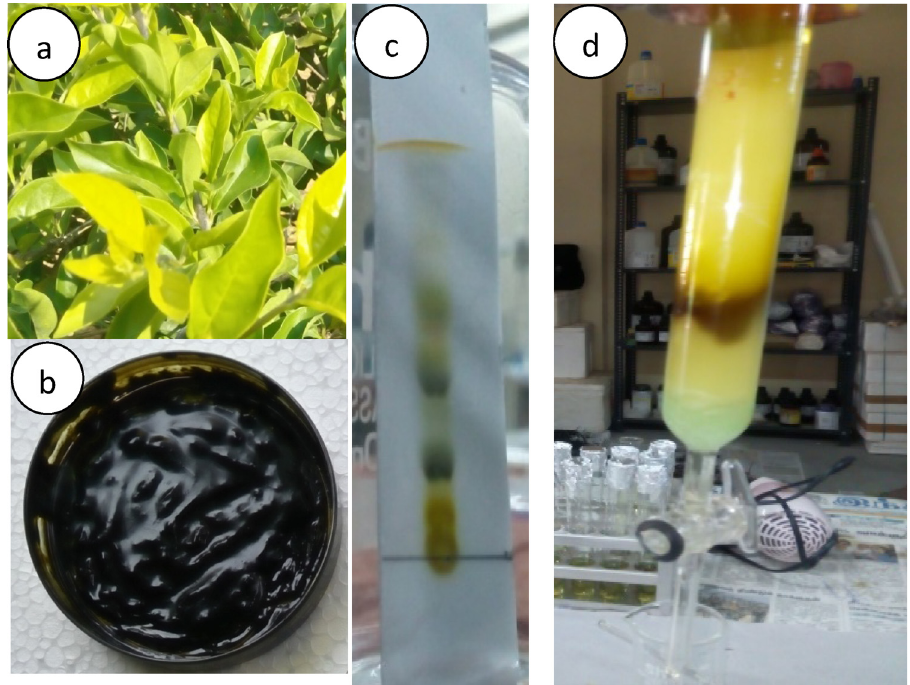
Figure 1: Phytochemical screening of LAE of A. monophylla . ( a ) Atalantia monophylla plant, ( b ) air - dried condensed LAE, ( c ) TLC, and ( d ) CC